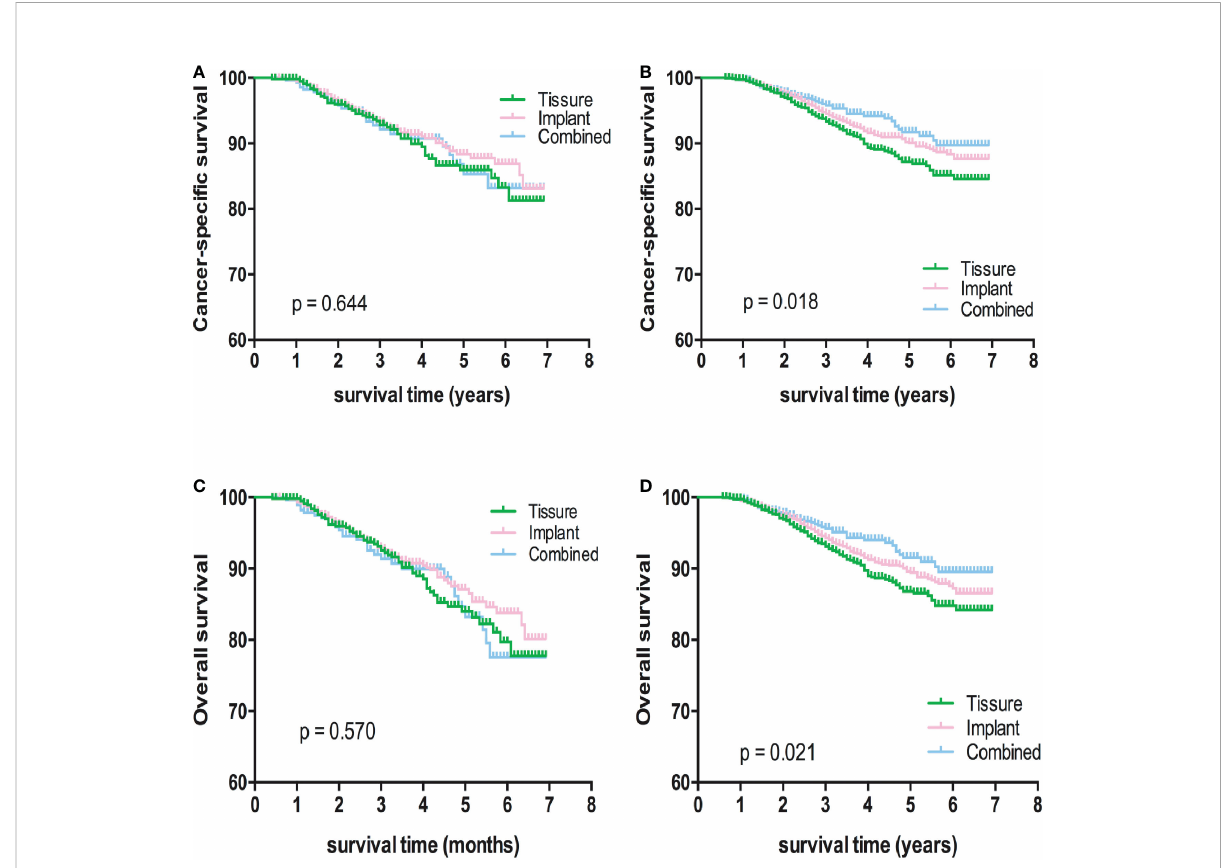
FIGURE 2 Kaplan-Meier analyses of CSS (A, B) and OS (C, D) among patients over or under 55 years strati fi ed according to reconstructive types.